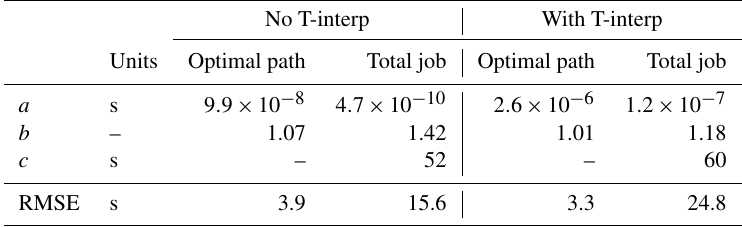
Table 3. Fit parameters for the data displayed in Fig. 3a. The fit model is a · x b + c . For the optimal path data, c parameter is not